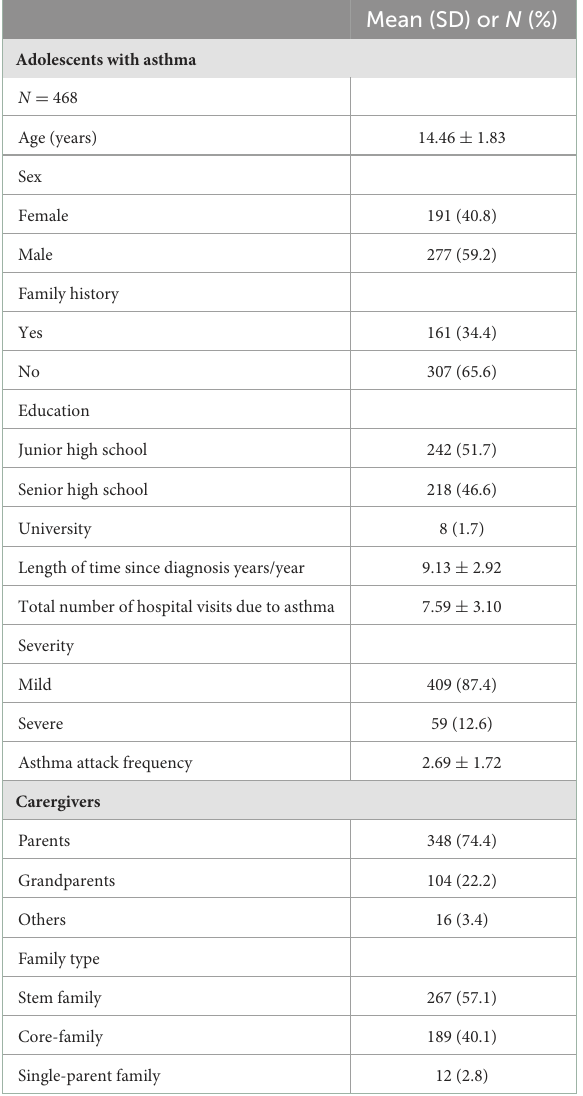
TABLE 1 Demographics of adolescents with asthma and family carers ( N = 468).